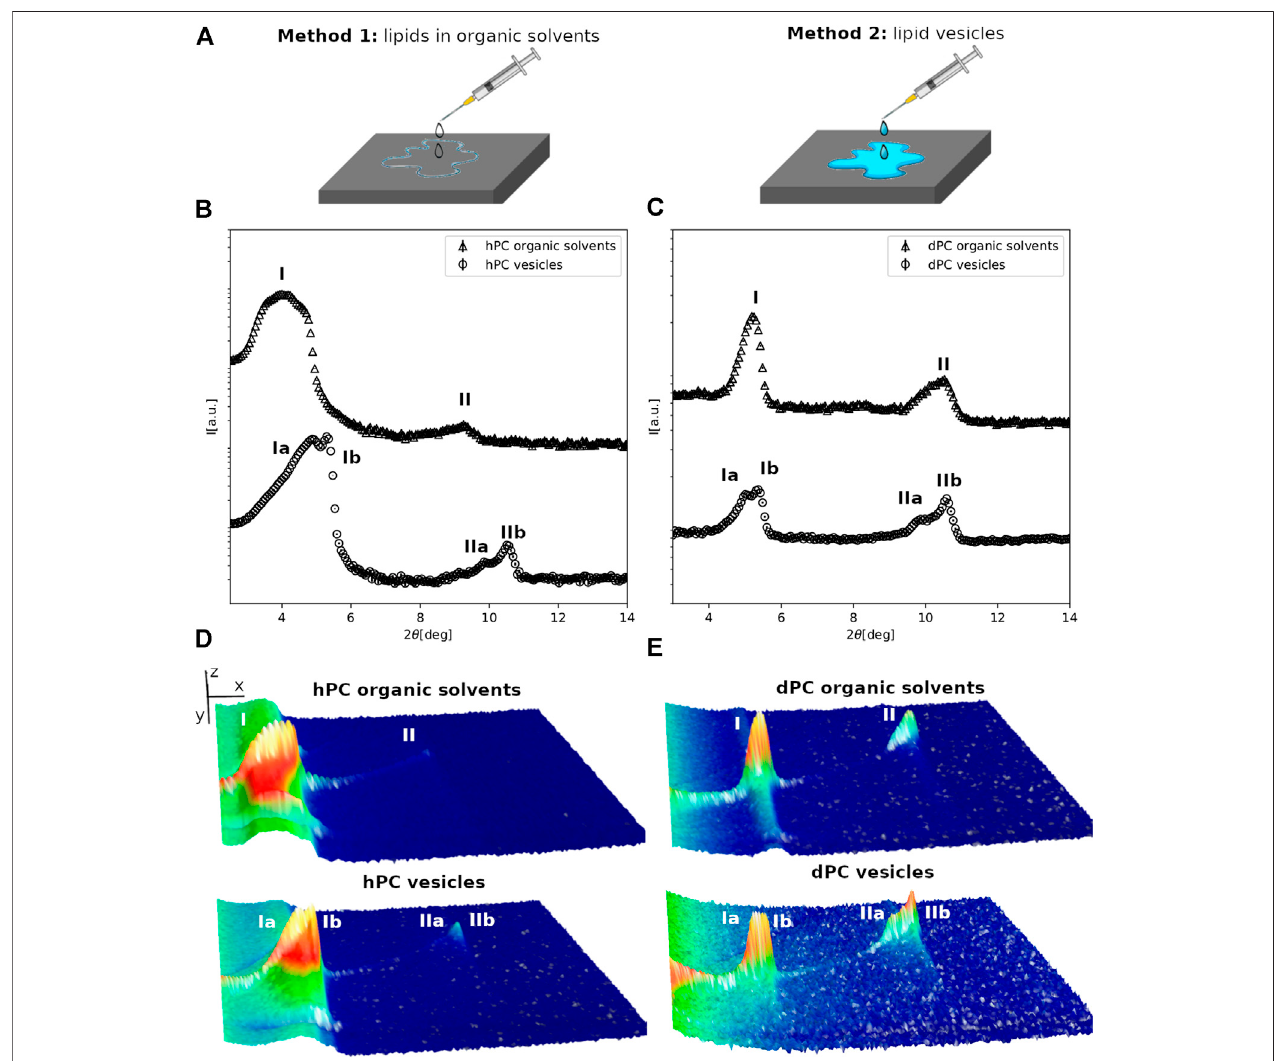
FIGURE 1 | (A) Schematic representation of the multilayer preparation methods. (B,C) Neutron diffraction data collected for hPC (A) and dPC (B) multilayers at 57%RH prepared with either method 1, i.e. deposition of lipids dissolved in an organic solvent solution or method 2, i.e. deposition of an aqueous vesicle suspension. (D,E) 3D representation ofthedetectorimagescorrespondingtothe diffraction pro fi les reported in (A,B) . In (D,E) the sample angle ( ω ) and the angle at the detector (2 θ ) are reported on the x and y direction respectively, while the intensity of the peak is reported on z direction. In (B – E) the different diffraction peaks are identi fi ed with Roman numbers, while the letters a and b are used to distinguish the different lipid